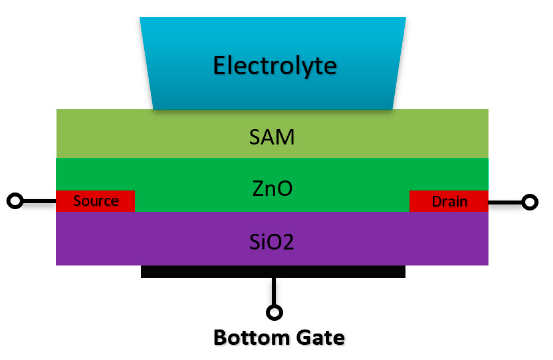
Figure 11. Double gate structure Chem/BioFET designed based on the double gate structure. The SiO 2 is placed at the back of the channel (ZnO) and the electrolyte solution has been placed on top of the sensing layer on top of the conductive channel.